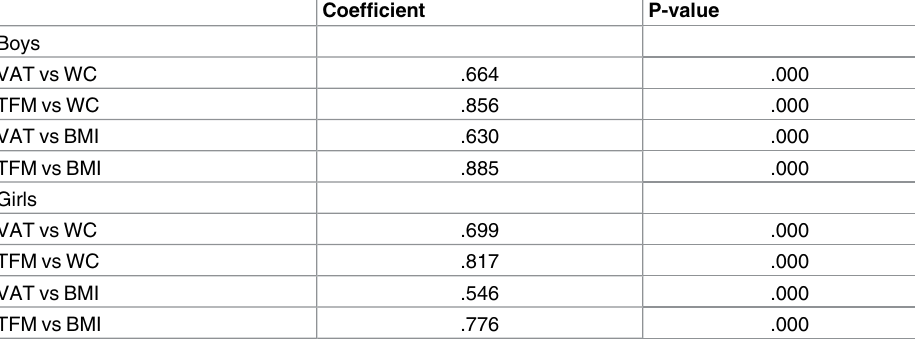
Table 4. Correlation coefficients for VAT and TFM with anthropometric